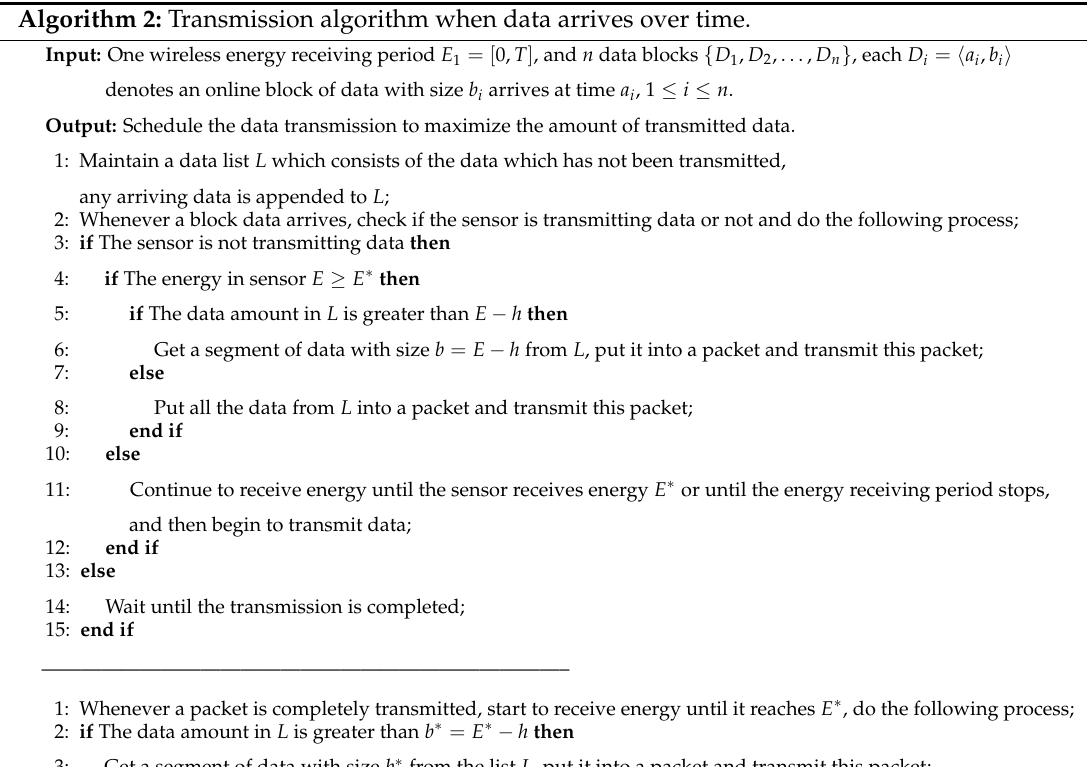
Algorithm 2: Transmission algorithm when data arrives over